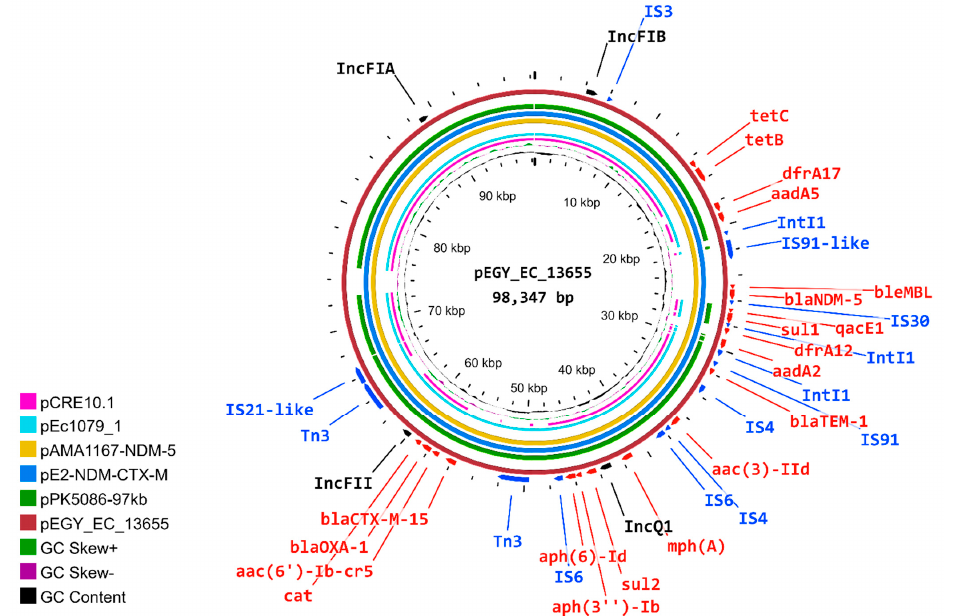
Figure 5. Circular comparison of pEGY_EC_13655 with the most similar IncFIA/IncFIB/IncFII/IncQ1 plasmids carrying ESBL-encoding genes from the NCBI database generated by CGView Server. The innermost circles show the plasmid coordinates, GC content (black), and GC skew (dark green and magenta). Circles from inside to outside correspond to the coding sequencing region of pCRE10.1 (CP034401.1), pEc1079_1 (CP081307.1), pAMA1167-NDM-5 (CP024805.1), pE2-NDM-CTX-M (CP048916.1), pPK5086-97kb (CP080372.1), and pEGY_EC_13655 (ON707124). Genomic regions covered by BLASTn are represented by a solid color in concentric rings, whereas white gaps indicate genomic regions not covered by BLASTn. Antibiotic-resistance genes (ARGs) are illustrated in red color, while insertion sequences and transposases are shown in blue color.